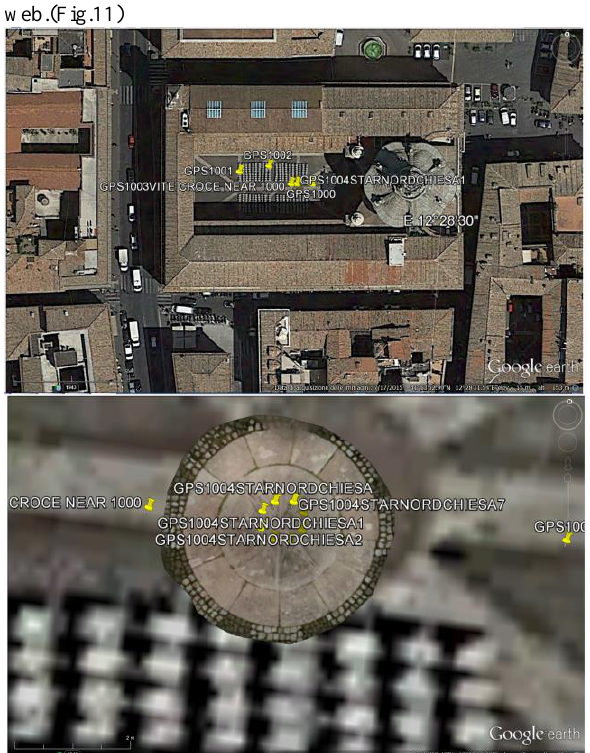
Figure 11. Chigi emblem KMZ format import in Google Earth